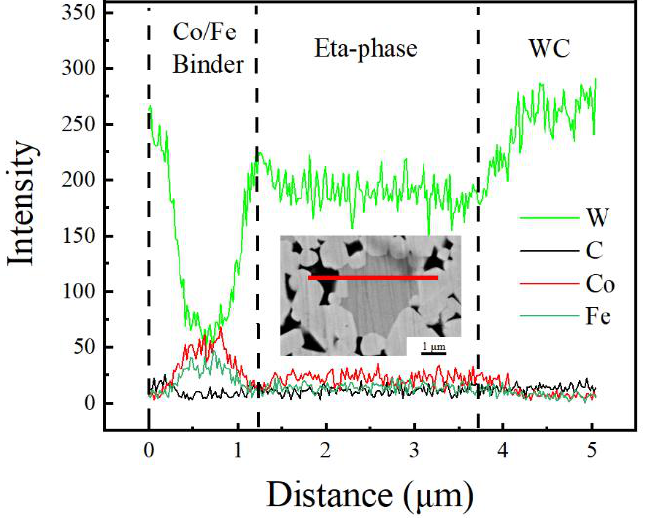
Figure 7. Elements’ distribution of binder phase, eta phase and WC phase in the 2Fe-5.3C sample. To sum up, for the sample without an eta phase such as 2Fe-6.3C, Fe mainly exists in the binder, forming a solid solution with B2 ordered structure (Figure 2). When the WC-13 (Co-Fe) composite is sintered at low-carbon content, such as 1Fe-5.3C, 2Fe-5.3C, 3Fe-5.3C, 4Fe-5.3C, 2Fe-5.1C and 2Fe-5.5C, Fe exists in both the eta phase and B2 ordered binder, which has been confirmed by EDS analysis in Figure 6. In the eta phase, Fe occupies the Co position instead of the W position, which can be identified by comparing the diffraction peaks of the eta phase of 0Fe-5.3C and 2Fe-5.3C samples in Figure 2. If Fe occupies the W position, the lattice constant will be greatly changed due to the large difference between the atomic radii of Fe and W. Figure 8 demonstrates the schematic diagram of atomic occupancy of Fe in the lattice of WC-13 (Co-Fe)